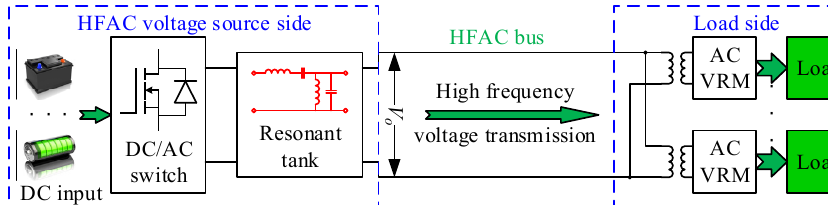
Figure 1. Structure diagram of HFAC PDS.